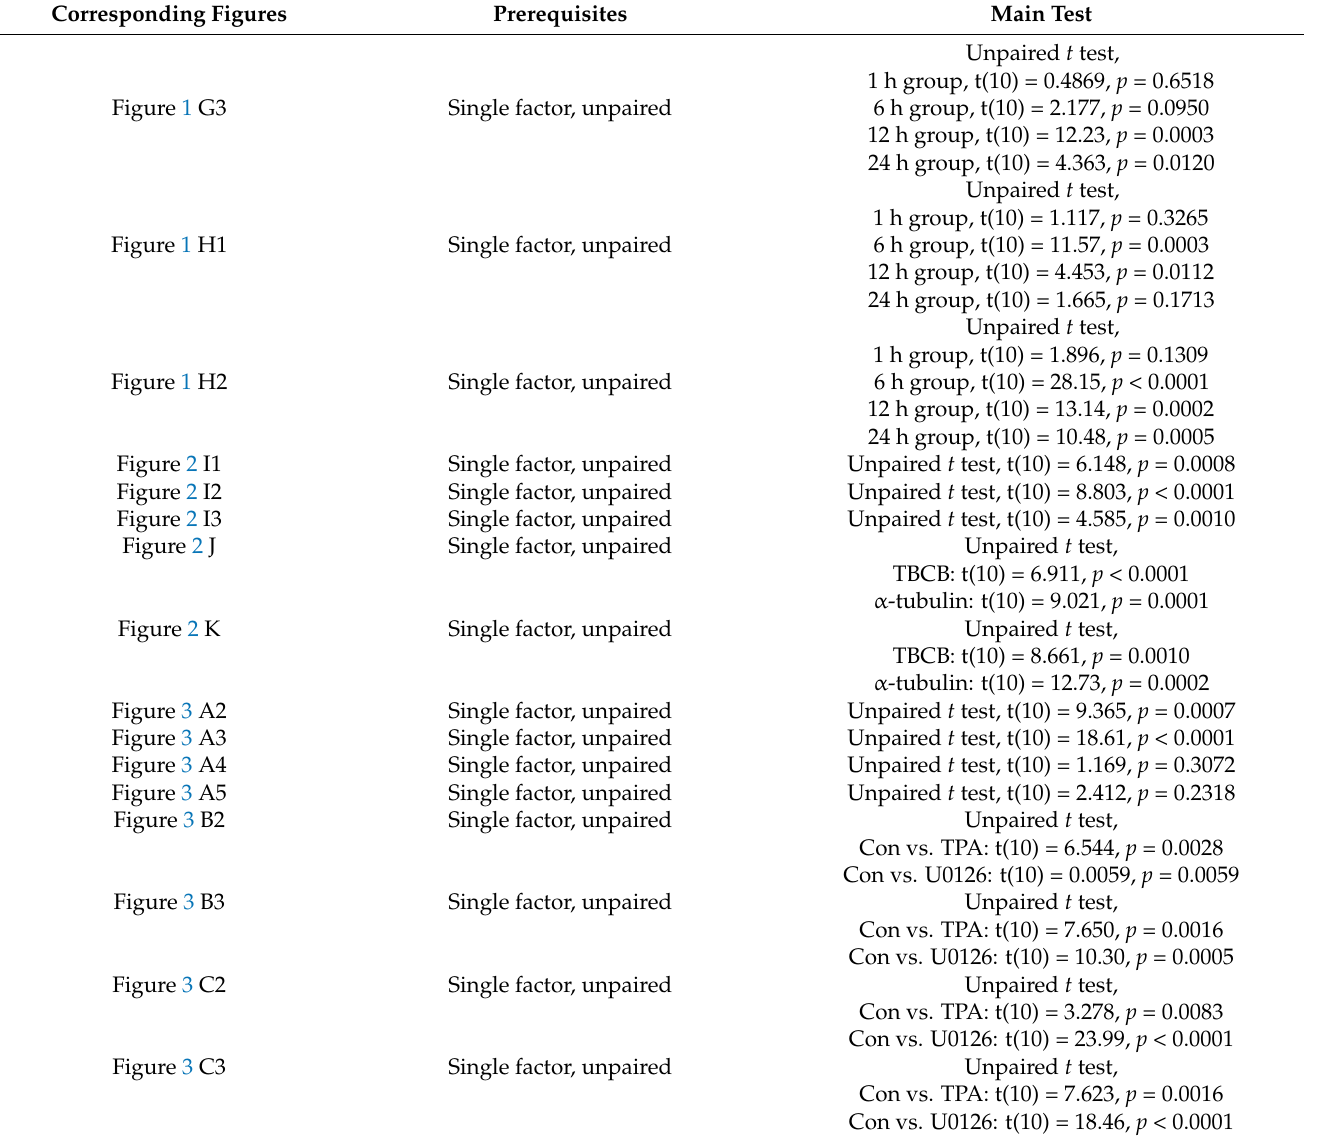
Con vs. TPA: t(10) = 7.623, p = 0.0016 Con vs. U0126: t(10) = 18.46, p <